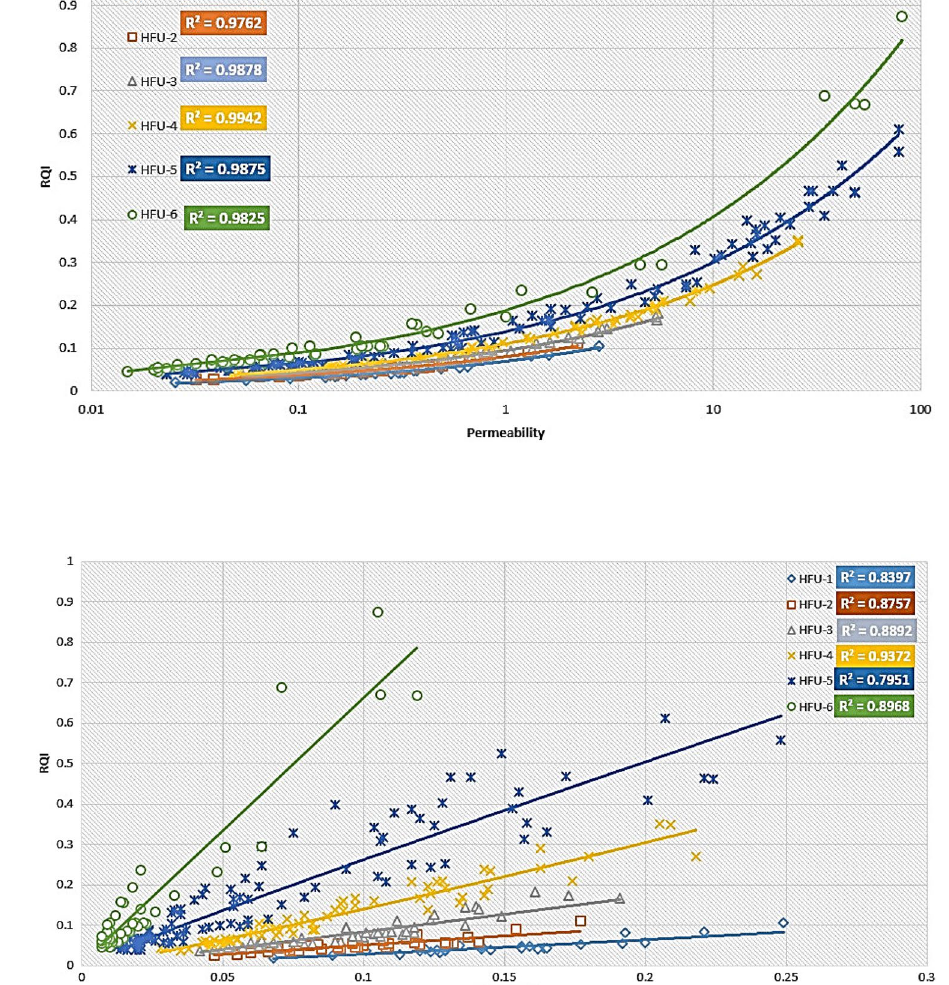
Fig. 16 Relationship between Permeability vs. RQI plot with a correlation coefficient higher than 0.9 for all categories